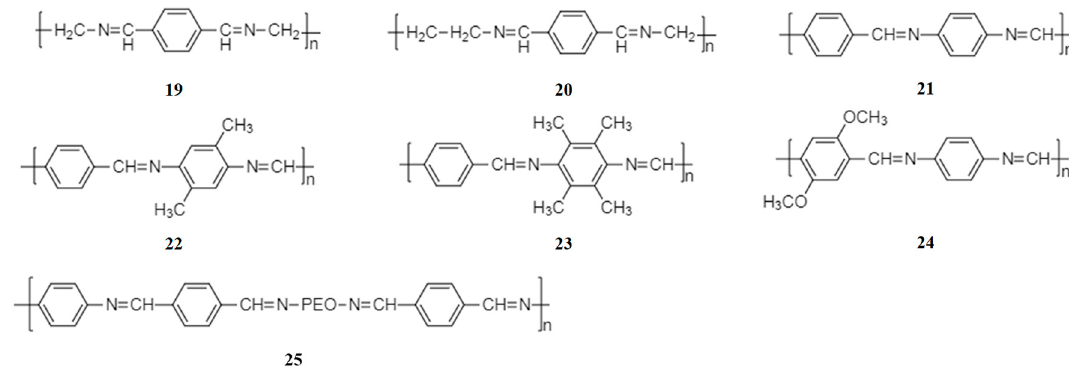
Figure 5. Structure of Schiff base polymers.